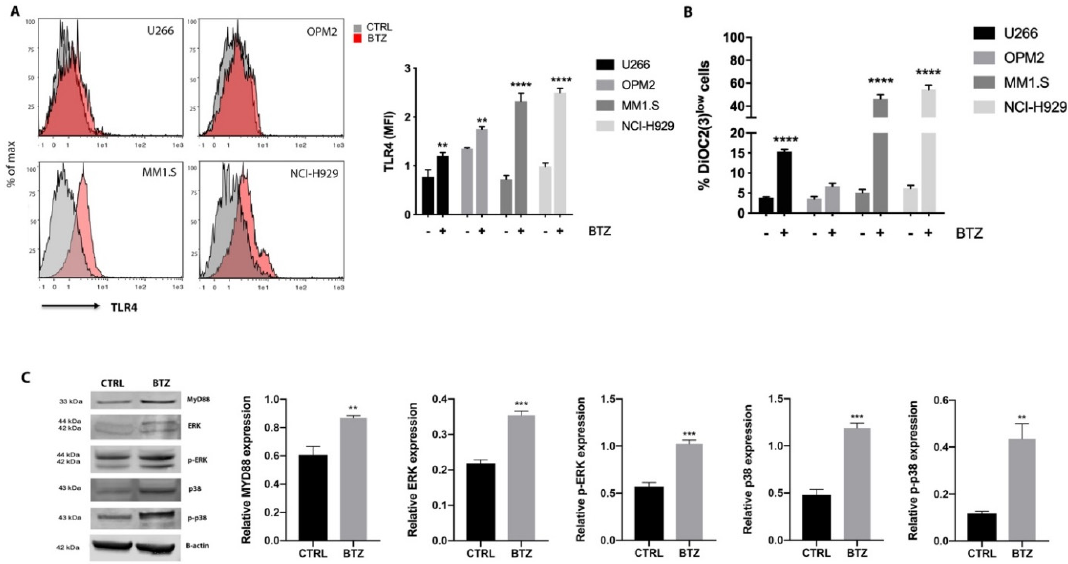
Figure 2. Bortezomib (BTZ) treatment activated TLR4 signaling. ( A ) Flow cytometric analysis for TLR4 expression of multiple myeloma (MM) cell lines after exposure to BTZ for 24 h.